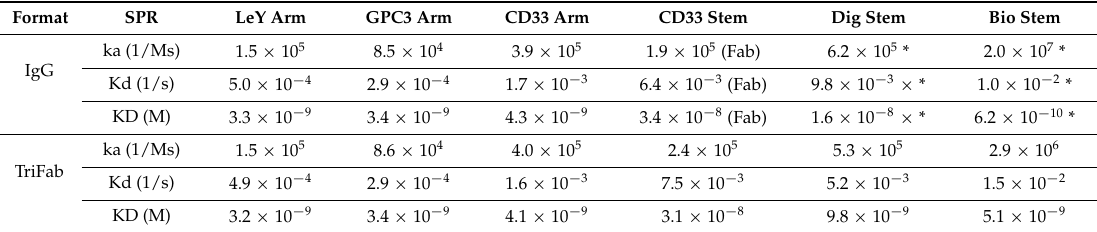
Antigen binding properties of TriFabs. Surface plasmon resonance